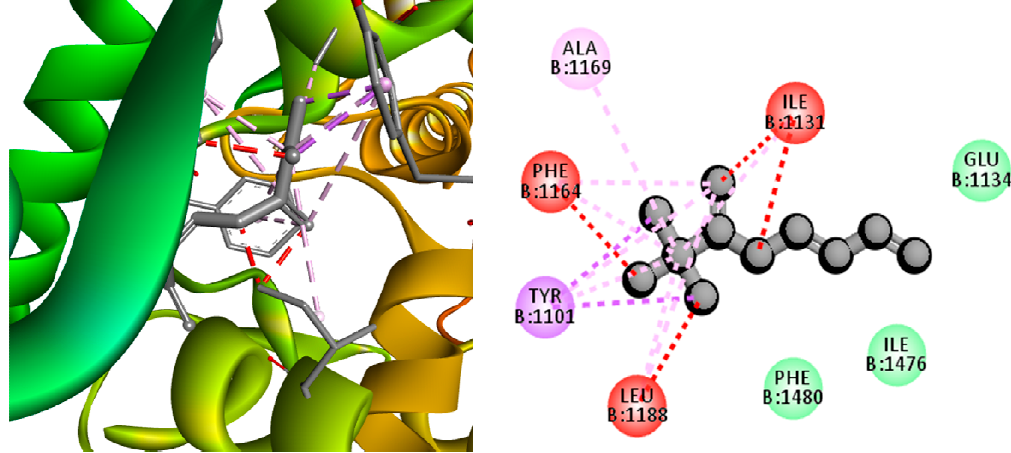
Figure 9. 3D and 2D docking pose showing the interactions between 2,3,3-trimethyl-Octane and bacterial topoisomerase inhibitors (NBTIs) protein.